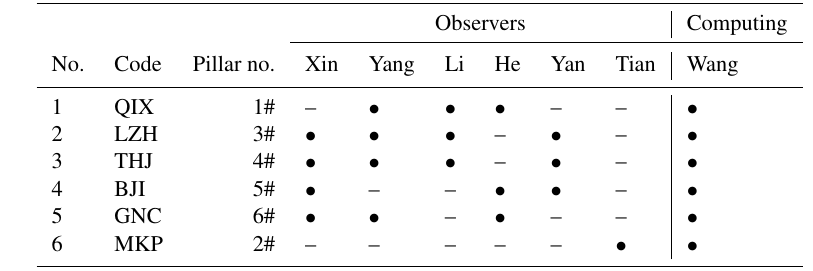
Table 1. The code and position of the fluxgate theodolites and the observer order.